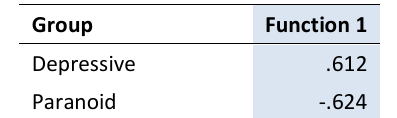
Table 6: Parameters of the isolated discriminant